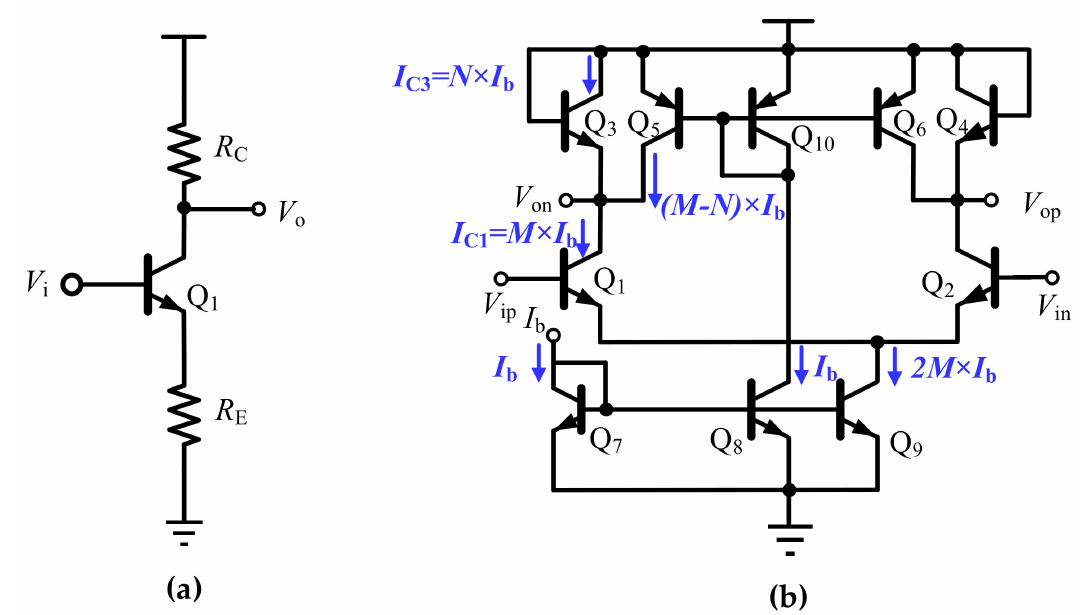
Figure 6. Schematic of ( a ) the typical common emitter gain cell with emitter degeneration; ( b ) the gain cell with the conventional diode-connected transistor load.